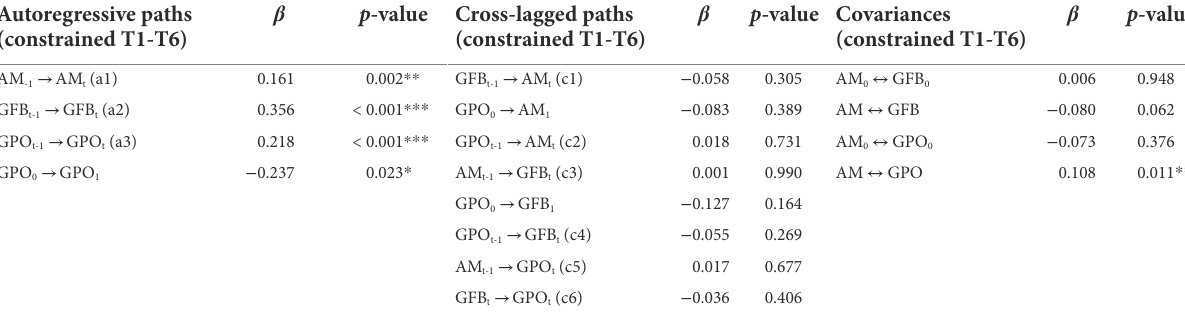
TABLE 3 Standardized RI-CLPM parameter estimates for Objective Progress Model. Autoregressive paths (constrained